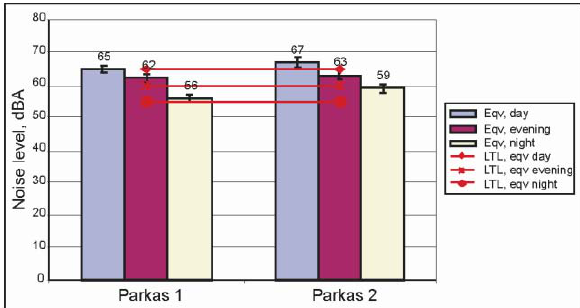
Fig. 18. Dynamics of equivalent noise levels in Parkas street within twenty four hours